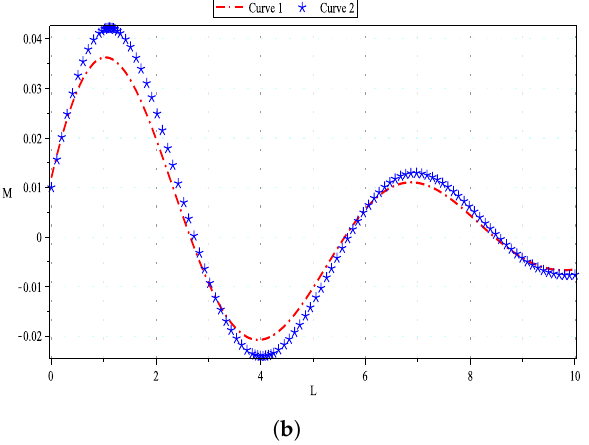
Figure 11. ( a ) reflects the analysis of the system letting the initial conditions ( u , v ) = ( 0.0,0.055 ) and ( u , v ) = ( 0.0,0.025 ) with (cid:101) = − 0.1, δ = 0.1, ν = − 2.5, θ = 1, and C = 0.001. It is indeed important to see that overlapping can be observed between the curves. ( b ) Here, we take the initial conditions ( u , v ) = ( 0.01,0.055 ) , the results of which are shown by the red curve and those of ( u , v ) = ( 0.012,0.045 ) represented by the blue